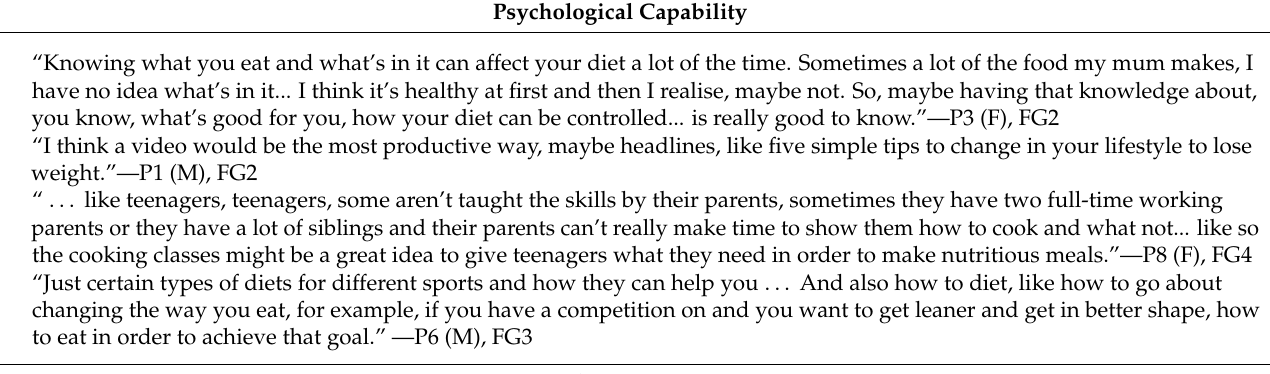
Table 3. Exemplar quotes from adolescents by key